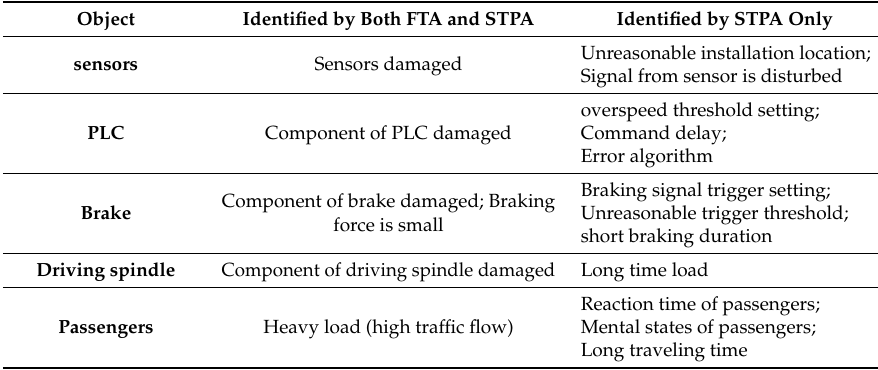
Table 8. Analysis result comparison between fault tree analysis (FTA) and system-theoretic process analysis